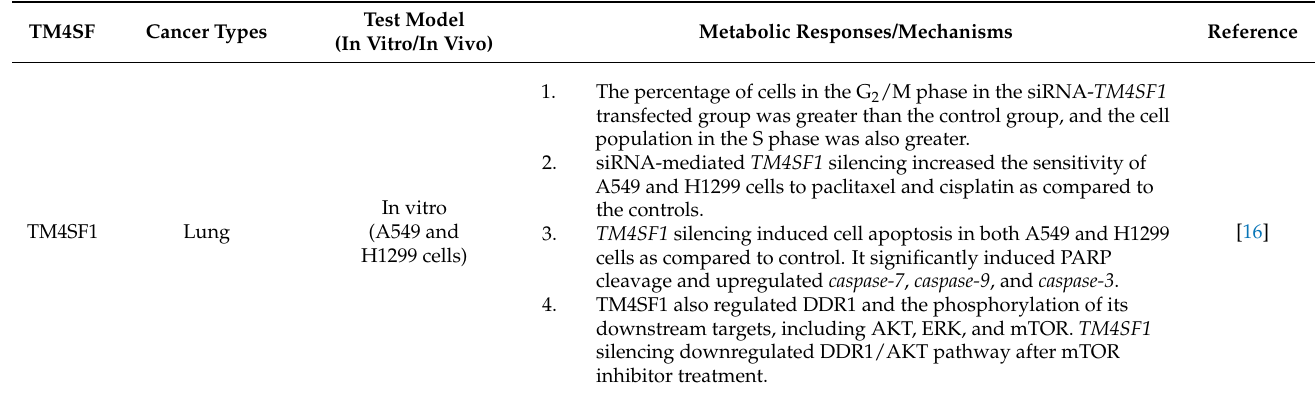
Table 4. Regulatory roles of TM4SF1, TM4SF4, and TM4SF5, and the underlying mechanism of actions against chemoresistance in